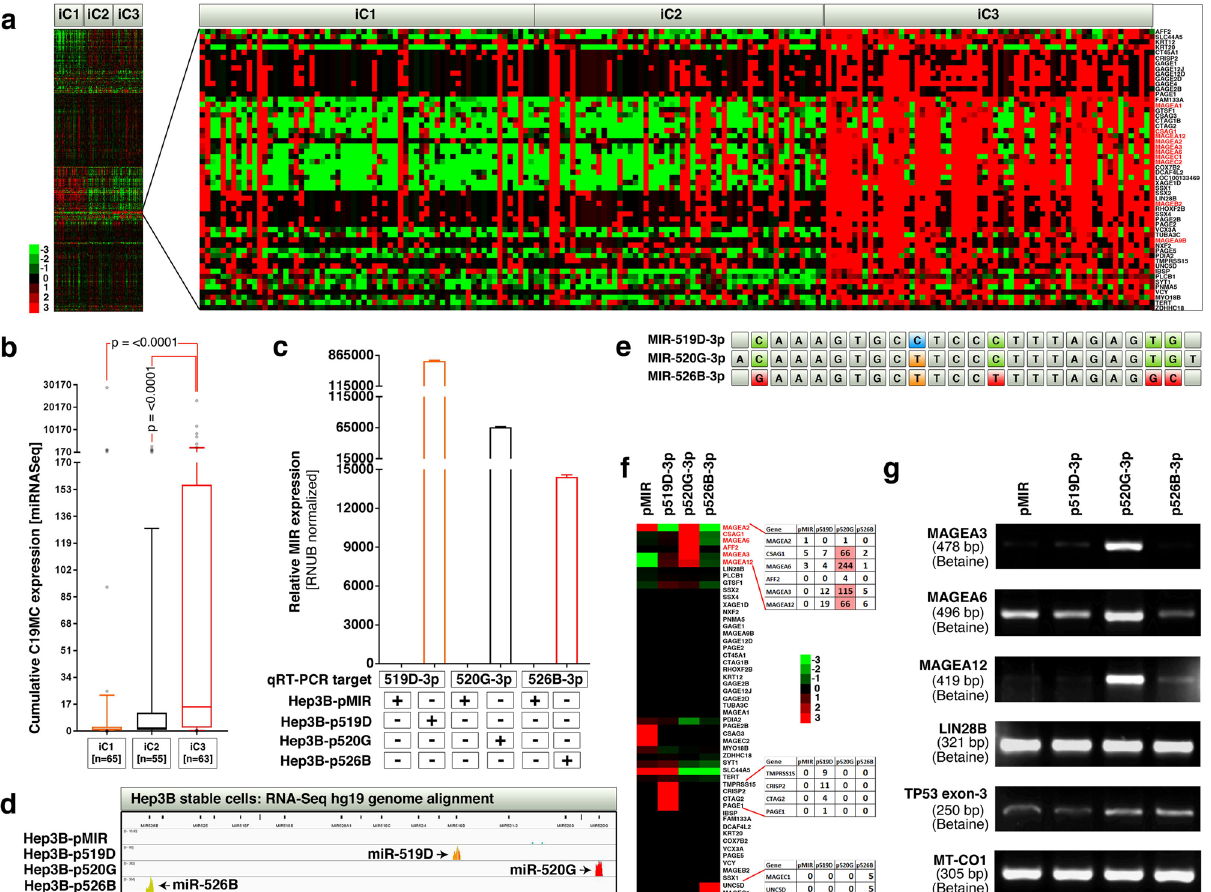
Figure 1. C19MC overexpression marks MAGEA expressing HCC iCluster-3 and miR-520G promotes the expression of MAGEAs-3, 6, and 12. ( a ) LIHC (HCC) iClusters showing overexpression of cancer testis antigens in iCluster-3. Melanoma antigens are shown in red font. ( b ) HCC iClusters showing overexpression of C19MC miRNAs in iCluster-3. Stably transfected Hep3B cells with C19MC miRNAs were confirmed by qRT-PCR ( c ) and RNA-seq ( d ). ( e ) Nucleotide differences between mature miR-519D, miR-520G, miR-526B. ( f ) RNA-seq heatmap of cancer testis antigens upregulated (in LIHC/HCC iCluster-3: panel-A) in Hep3B stable cells expressing miR-519D, miR-520G, miR-526B. Genes in red fonts are specific for miR-520G. ( g ) Reverse transcriptase PCR confirmation of MAGEA upregulation by miR-520G in Hep3B stable cells. LIN28B was selected in addition to